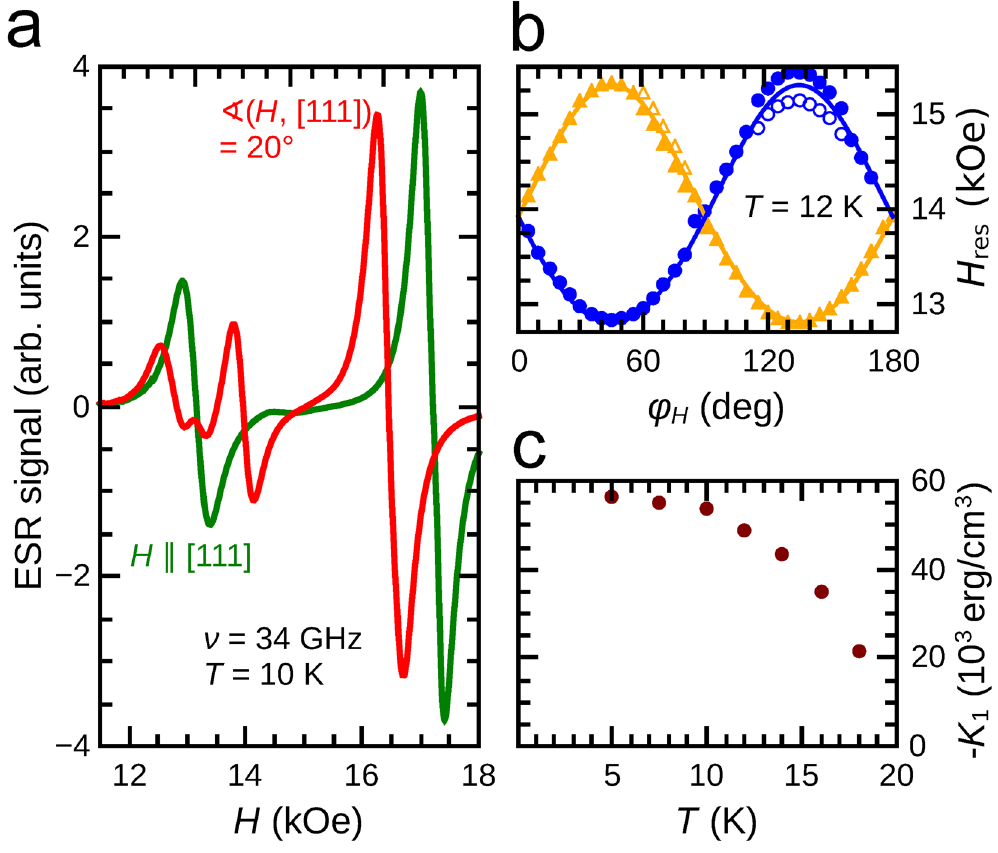
Figure 2. Magnetic anisotropy of GaV 4 Se 8 . ( a ) Electron spin resonance spectra for the external field H applied along a rhombohedral axis (green curve) and tilted by 20° away from it (red curve). ( b ) Resonance fields (symbols) for the magnetic field rotated within the (001) plane, where ϕ H is the angle between the field and the [001] direction, i.e. 0°, 45°, 90° and 135° correspond to the [100], [110], [010] and [1 1 0] axes, respectively. Solid lines display a fit based on uniaxial anisotropy. ( c ) Temperature evolution of the anisotropy constant K 1 < 0, characteristic of easy-plane